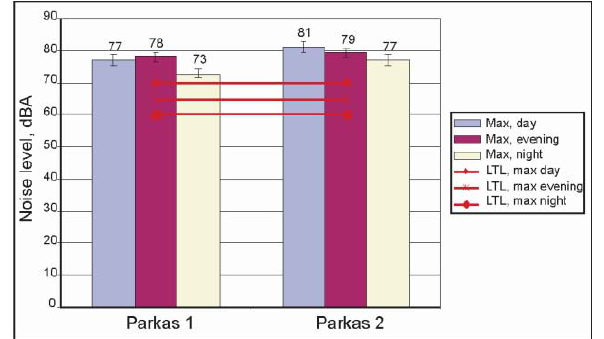
Fig. 19. Dynamics of maximum noise levels in Parkas street within twenty four hours